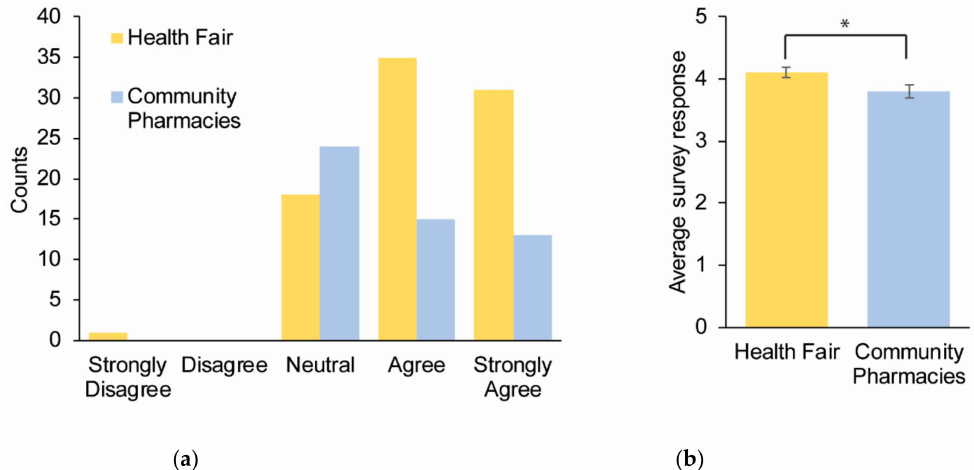
Figure 3. Survey responses to the question: “I believe that pharmacogenomics could help me”. A total of 137 participants provided responses across multiple sites and were subsequently categorized as the symposium ( n = 85) and community pharmacy ( n = 52) participants. ( a ) Cumulative responses for each category depicted by di ff erent colors for the two cohorts. ( b ) The average survey response for the two cohorts. Error bars =